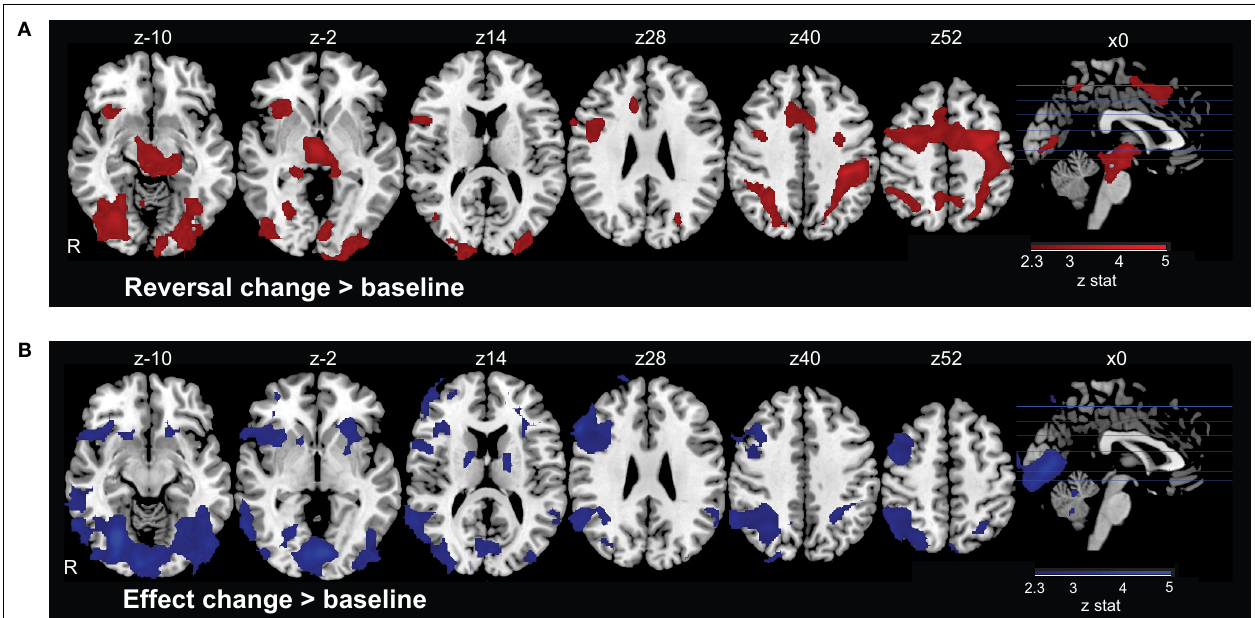
insular cortex, among other regions. (B) On Effect Change trials , only the visual effect of the action changes; the outcome has the same value, and the participant does not need to switch behavioral responses. Activation was again observed in lateral prefrontal and parietal cortices, along with regions of visual